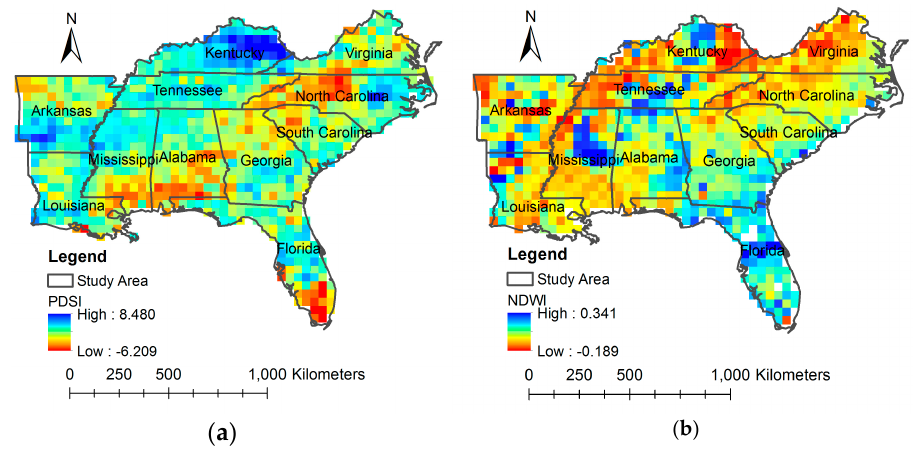
Figure 2. ( a ) Palmer drought severity index (PDSI) for April 2015. Areas in yellow and red represent areas that are experiencing dry conditions; ( b ) Normalized difference water index (NDWI) calculated for 01 to 03 April 2015. Likewise, areas in yellow and red represent areas that are experiencing low vegetation water content and therefore a dry